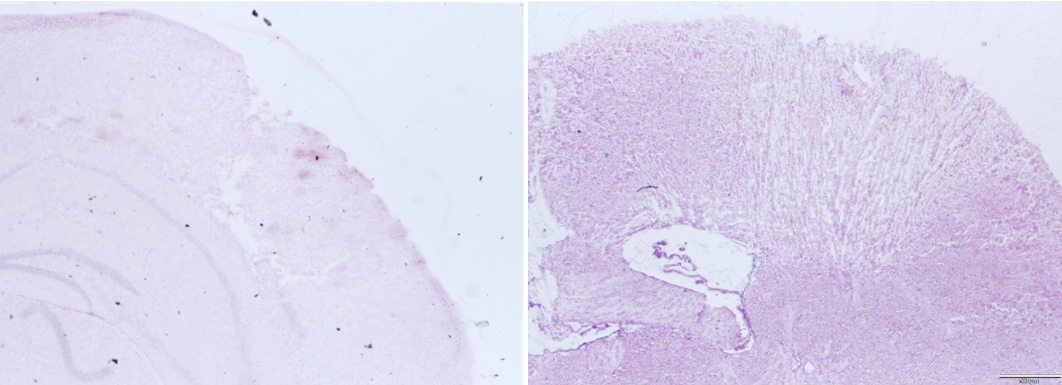
Figure 4. Histological preparations of the right neocortex 15 min after CCI ( left ) and 24 h after CCI ( right ).